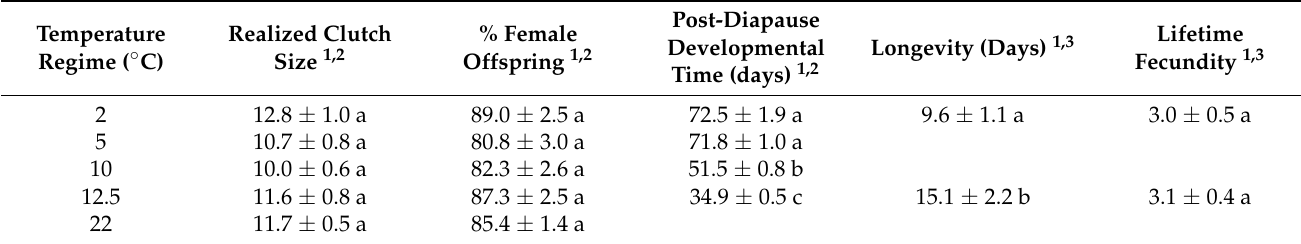
Table 2. Effects of temperature regimes (see Table 1) on the developmental time and post-diapause reproductive fitness of A. fukutai